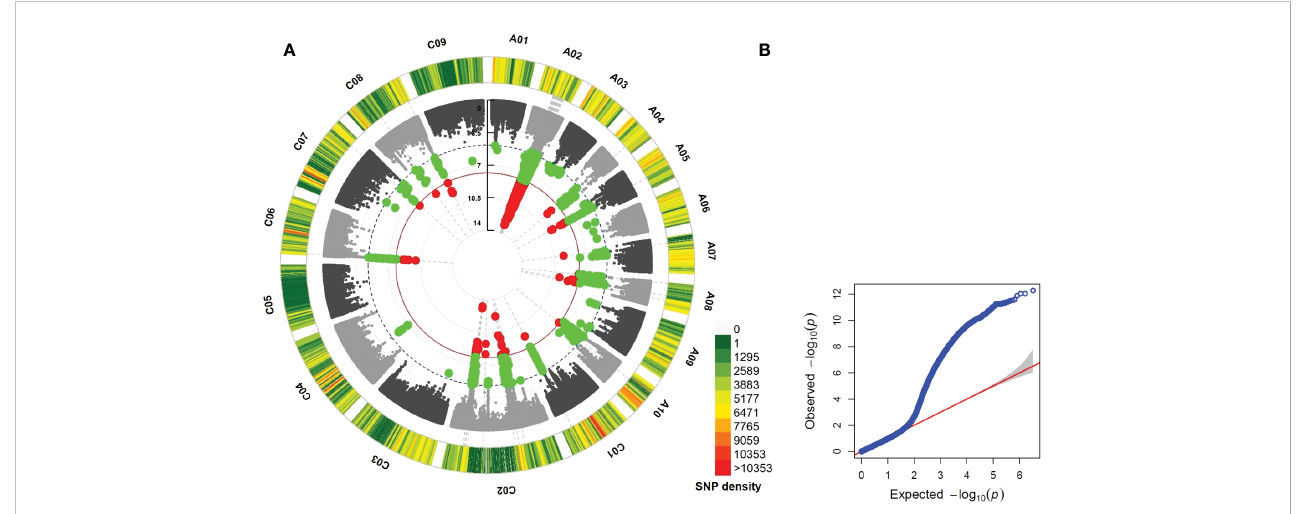
FIGURE 1 Circular Manhattan (A) and quantile-quantile (QQ) plots (B) showing the signi fi cant single nucleotide polymorphisms (SNPs) above the signi fi cance threshold line (red dot), 1.58 E-08, in mixed linear model (MLM) of genome wide association study in Brassica napus cv. Darmor bzh v9. Green dot refers to SNPs below the cut-off for signi fi cance having at least